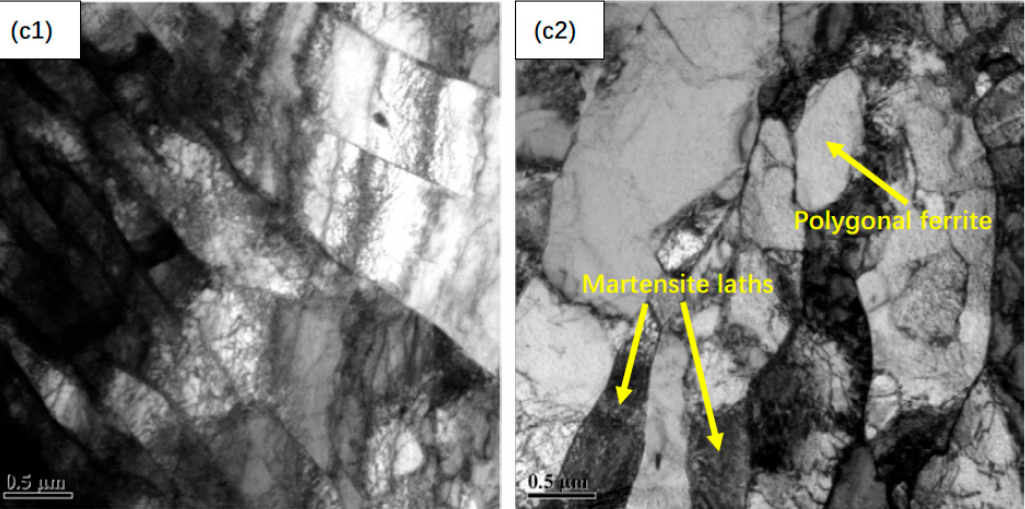
Figure 10. TEM images of the weld zone and base metal after creep-fracture for the different stress levels: ( a1 ) base metal, 160 MPa; ( a2 ) weld zone, 160 MPa; ( b1 ) base metal, 180 MPa; ( b2 ) weld zone, 180 MPa; ( c1 ) base metal, 220 MPa; and ( c2 ) weld zone, 220 MPa.